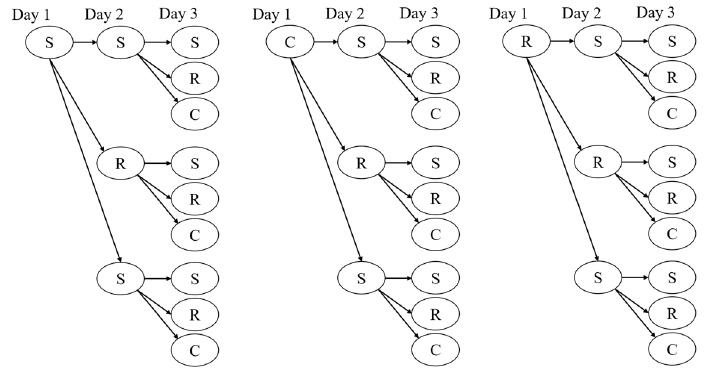
Figure 8. Three ‐ day weather pattern possibilities. Figure 8. Three-day weather pattern possibilities.